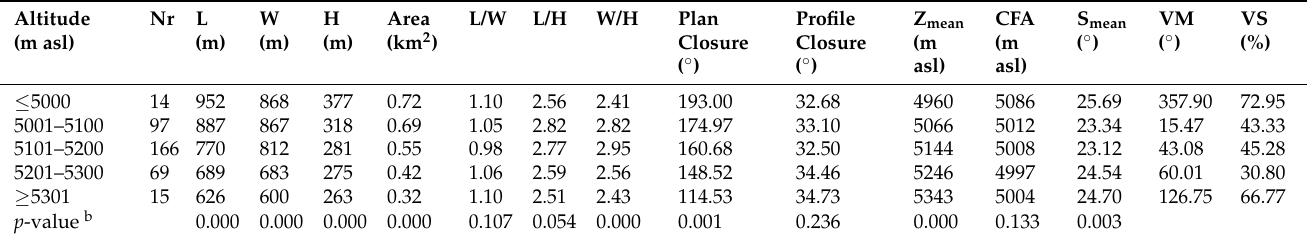
Table 3. Cirque metrics against altitude a .